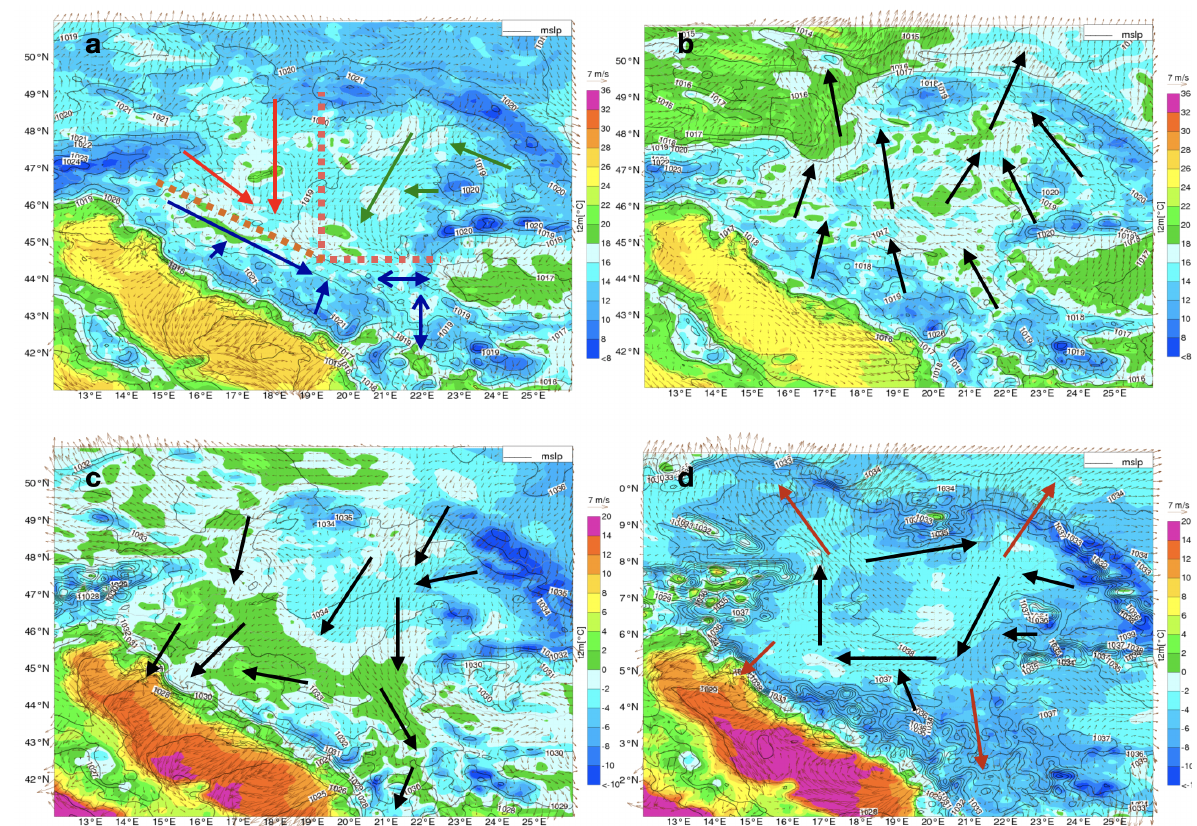
Figure 6. Different wind patterns when high pressure dominates over the Pannonian Basin ( a ) in the absence of well- defined pressure gradients (3 September 2016, 00 UTC), with red arrows in the Alpine-Drava region, green arrows in the Carpathian-Tisza region, blue arrows in the Dinarides-Sava region, and the dotted orange line roughly indicating the limits between these regions; ( b ) for lower pressure at the north (29 August 2016, 00 UTC); ( c ) for lower pressure at the south (16 December 2016, 00 UTC); and ( d ) for lower pressure regions at the north and south (22 December 2016, 00 UTC)—black arrows within-basin circulation, red arrows air that passes through outside the